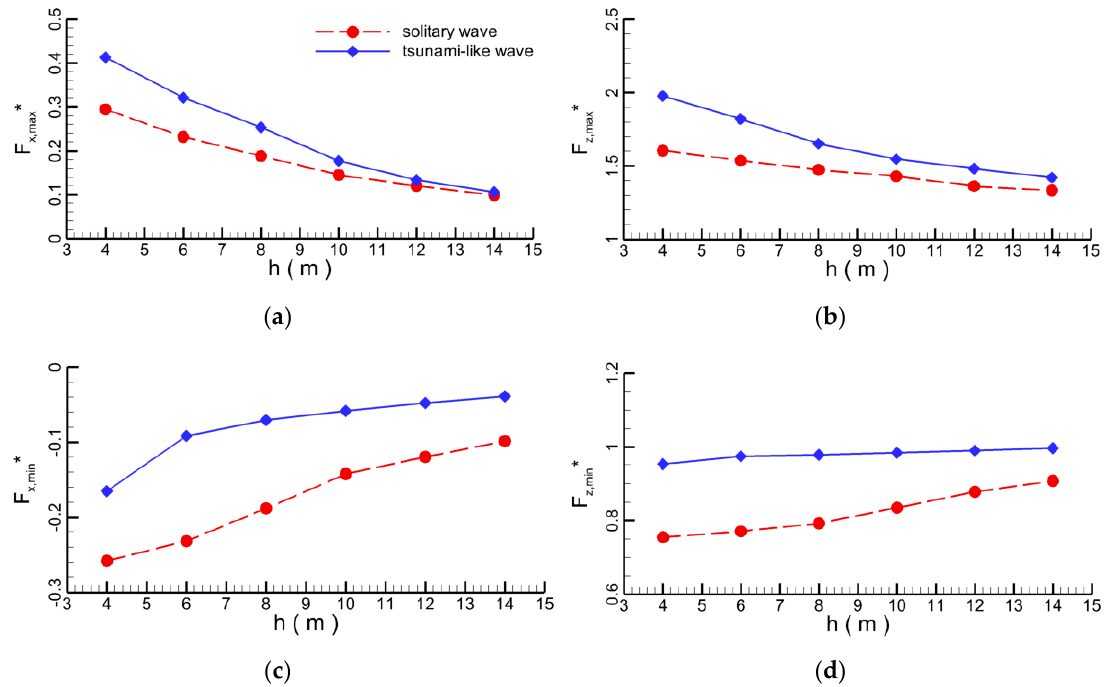
Figure 19. Plots of maximum forces as function of water depth; ( a ) maximum horizontal force F x,max *; ( b ) maximum vertical force F z,max *; ( c ) minimum horizontal force F x,min *; ( d ) minimum vertical force F z,min *.